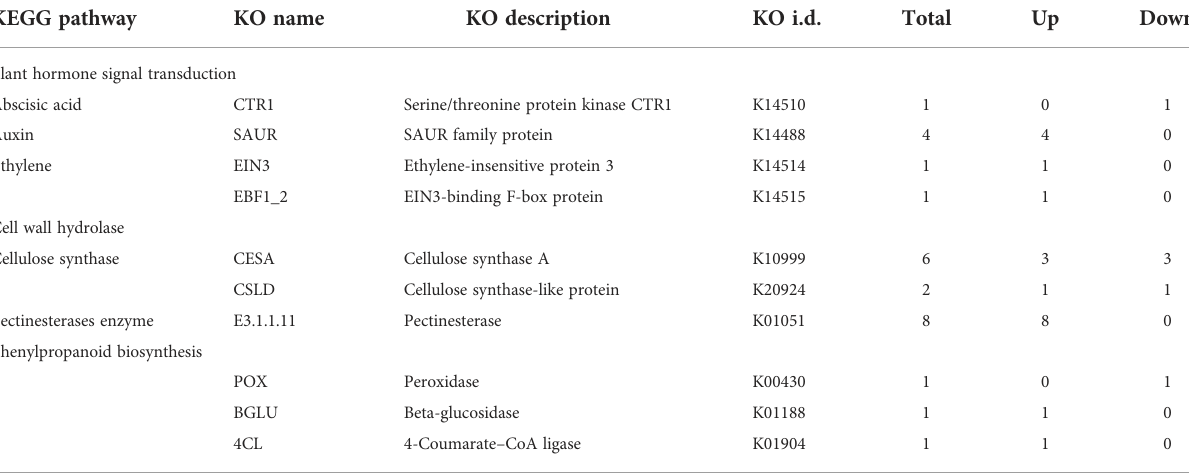
TABLE 7 Twenty-six candidate differentially expressed genes (DEGs) enriched in plant hormone signal transduction, cell wall hydrolase, and phenylpropanoid biosynthesis pathway. KEGG pathway